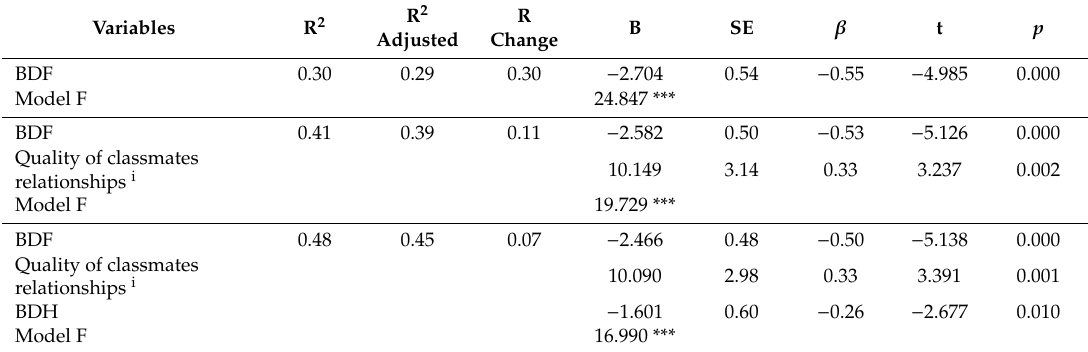
Table 5. Multiple linear regression model of Problematic Internet Use for male group (N =